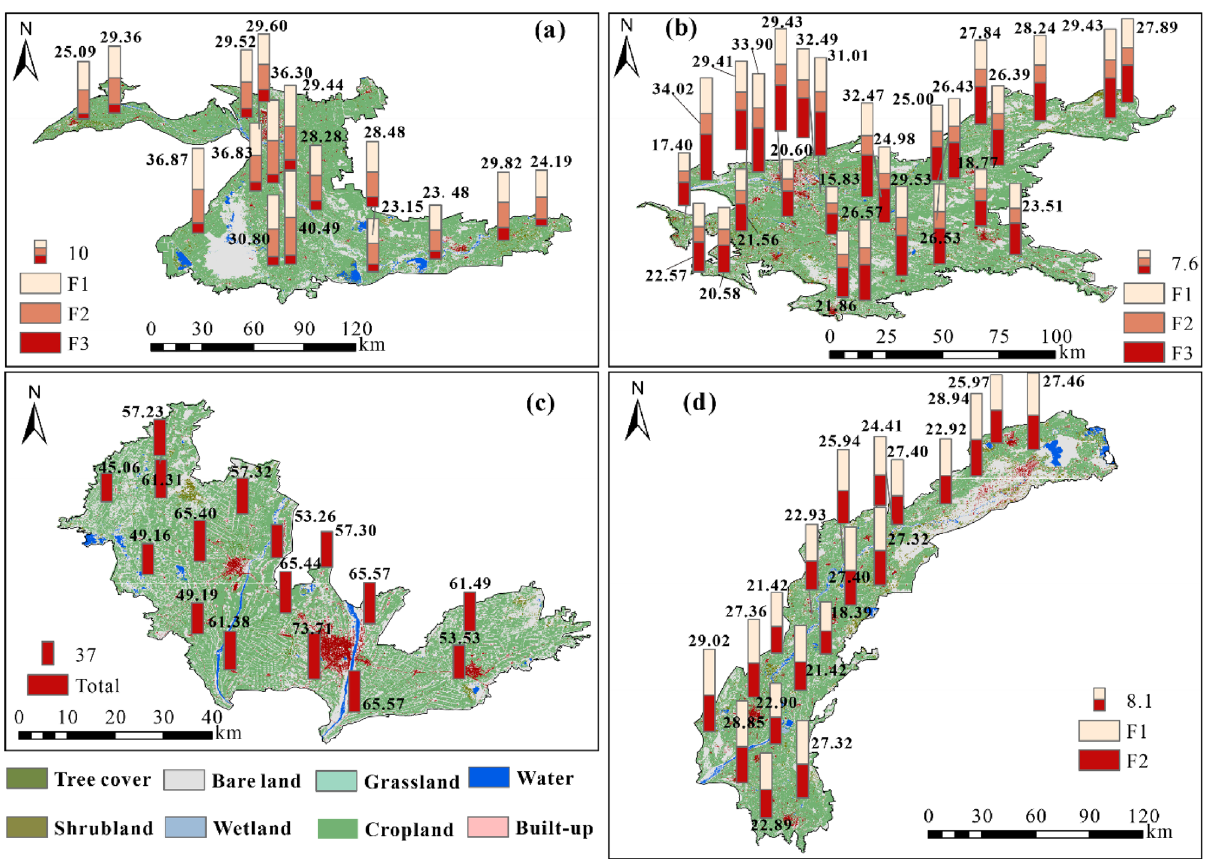
Figure 5. Spatial distribution of the ecological risks of PTEs from different sources in the four oases. The graphs were generated by QGIS 3.26.3 (https:// www. qgis. org) and the land use data are from the ESA global 30 m resolution land use cover dataset (https:// viewer. esa- world cover. org/ world cover). The combination of graphs ( a – d ) was accomplished with linkscape 1.2.1 (https:// inksc ape.